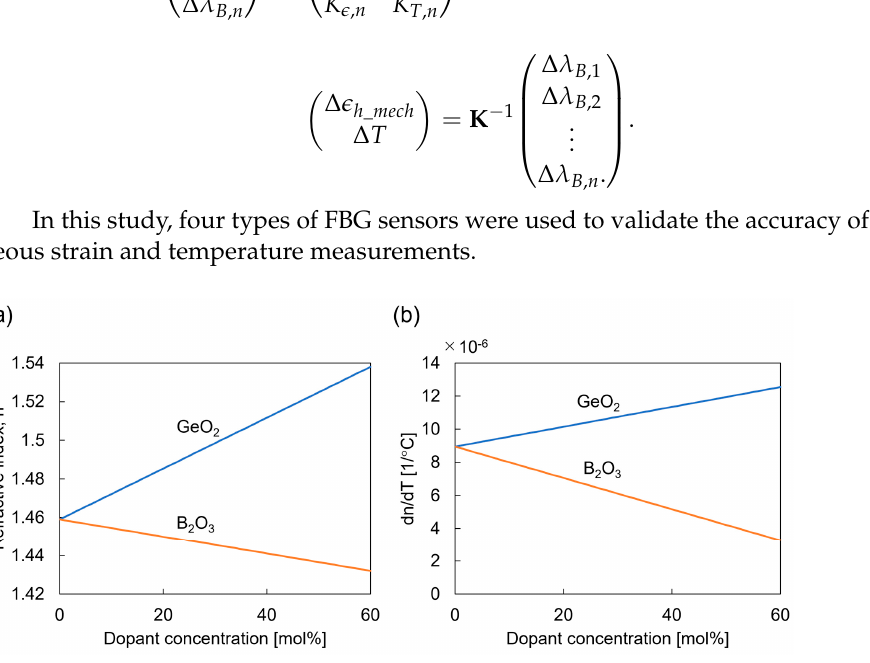
Figure 1. Variations in the respective parameters affecting the strain and temperature sensitivities as a function of the dopant concentration: ( a ) refractive index; ( b ) change rate of the refractive index with